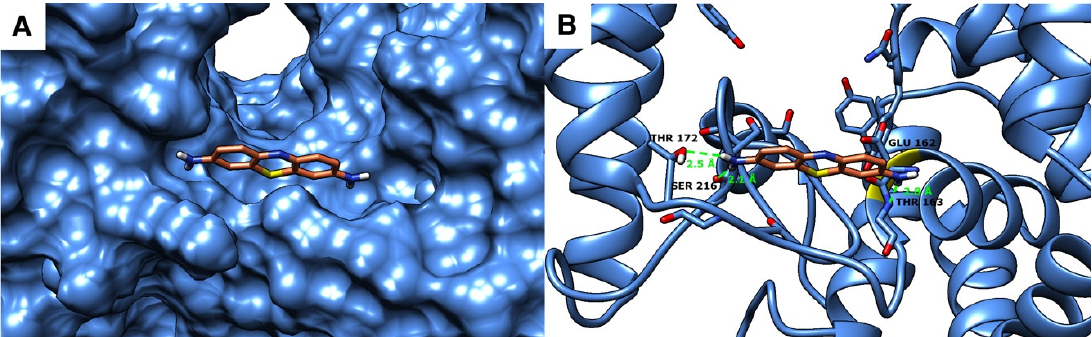
Figure 9. Predicted binding mode of thionine acetate with Slt35 (PDB 1QUS [49]). The enzyme is shown in blue as ( A ) a surface representation of the binding site and ( B ) a cartoon representation showing the amino acid residues (as sticks) located in the active site close to the inhibitor. The inhibitor is shown as orange sticks. The predicted hydrogen bonding interactions are shown as green dashes with distances in Å.